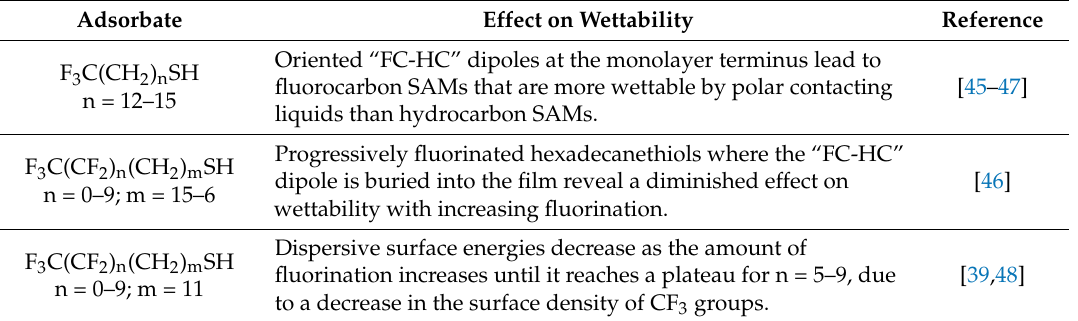
Table 1. Selected studies of partially fluorinated self-assembled monolayers (SAMs) in the literature. Adsorbate Effect on